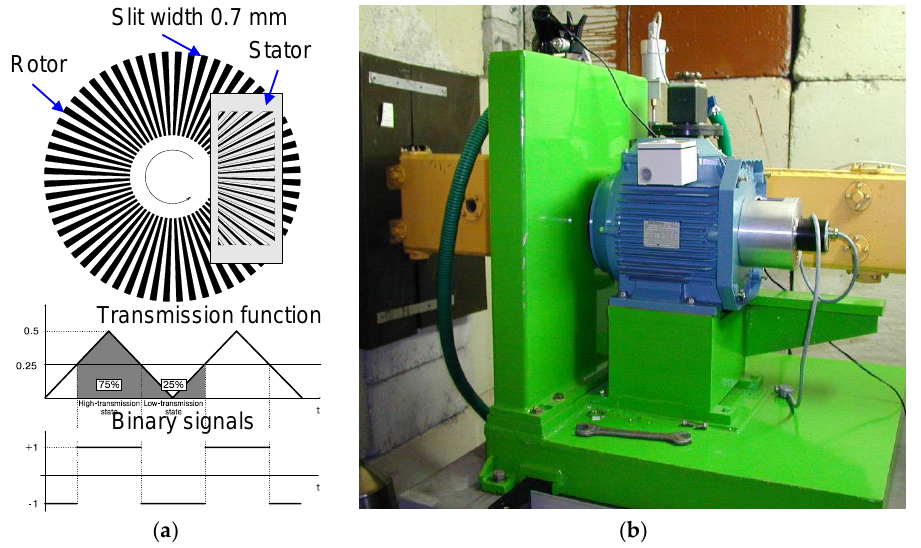
Figure 4. ( a ) Design of the Fourier chopper, consisting of a rotating rotor disk and a stationary stator. Outer circumference of the rotor disk is a system of interleaving slits transparent and opaque for thermal neutrons. The diagram below shows a saw tooth function of transmission of such a chopper system and its approximating sequence of positive and negative binary (pickup) signals; ( b ) Photo of the Fourier chopper installed on FSD.